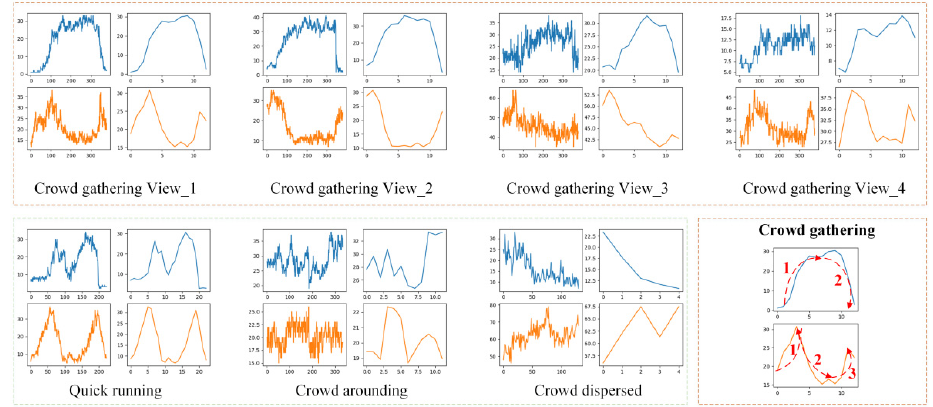
Figure 8. The original and final filtering results of crowd gathering and other crowd actions.